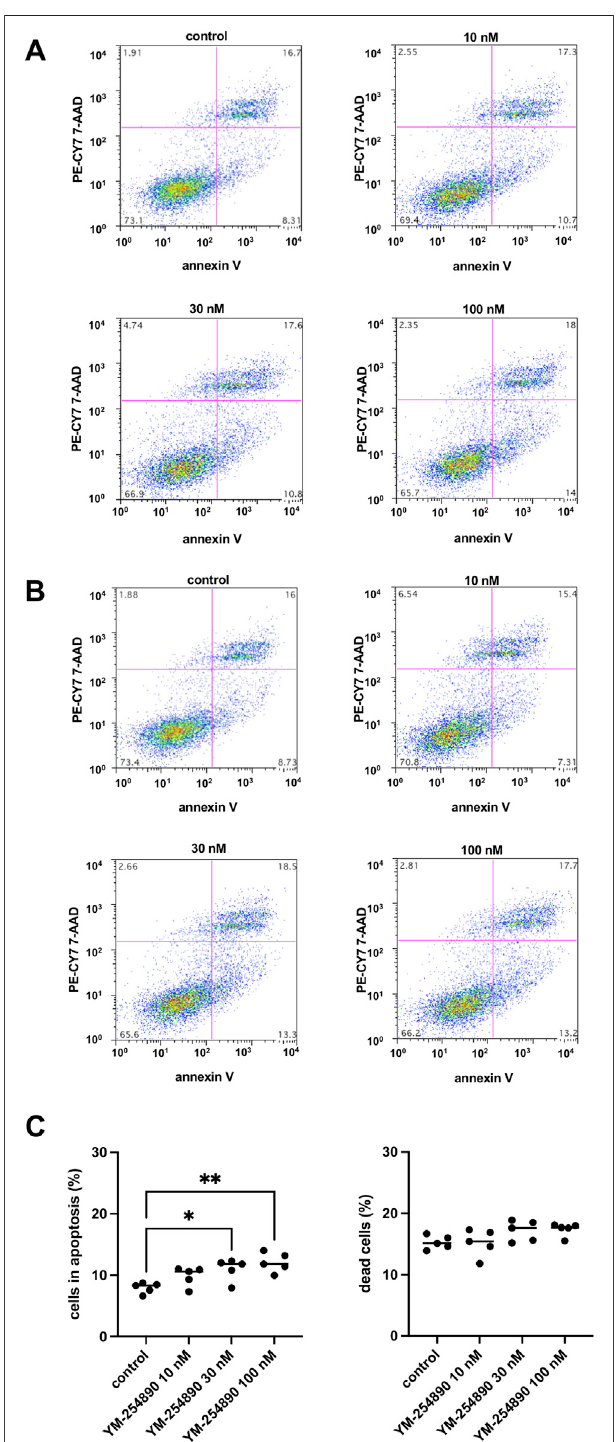
FIGURE 10 | Apoptosis (A) and cell death (B) in WPMY-1 cells after stimulation with YM-254890. Flow cytometry was performed, after cells were treated for 72 h with YM-254890 (10, 30, and 100 nM) or equal amount of solvent (DMSO, 10 μ l/ml) for controls. Subsequently, the numbers of cells in apoptosis (annexin V-positive, 7-AAD-negative), and of dead cells